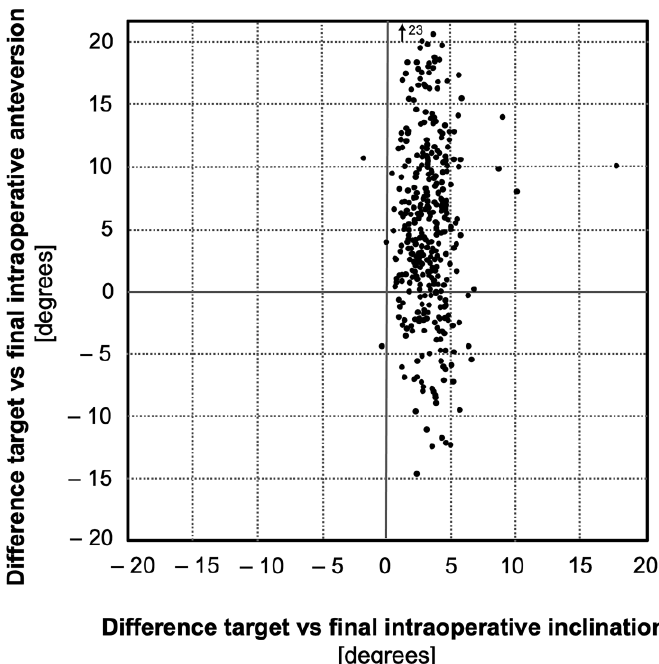
Figure 3. Difference between target and intraoperative positioning assessed by the navigation system (‘individual adjustment’).